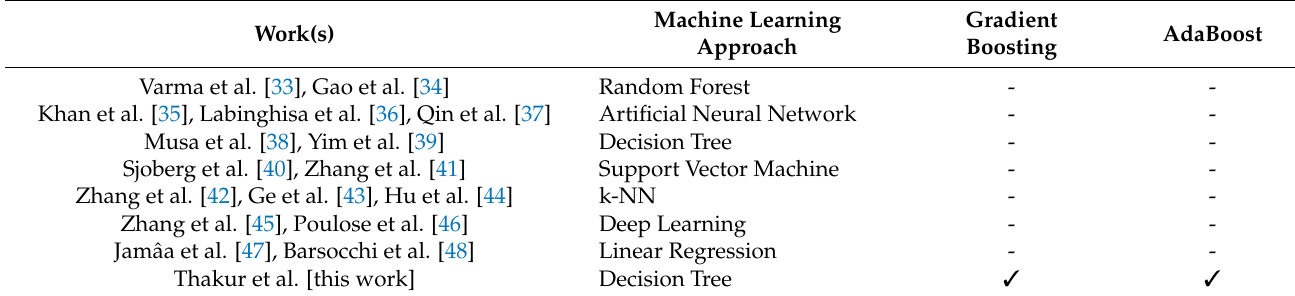
Table 5. Comparison of our proposed framework with other similar works in this field that used machine learning approaches for indoor